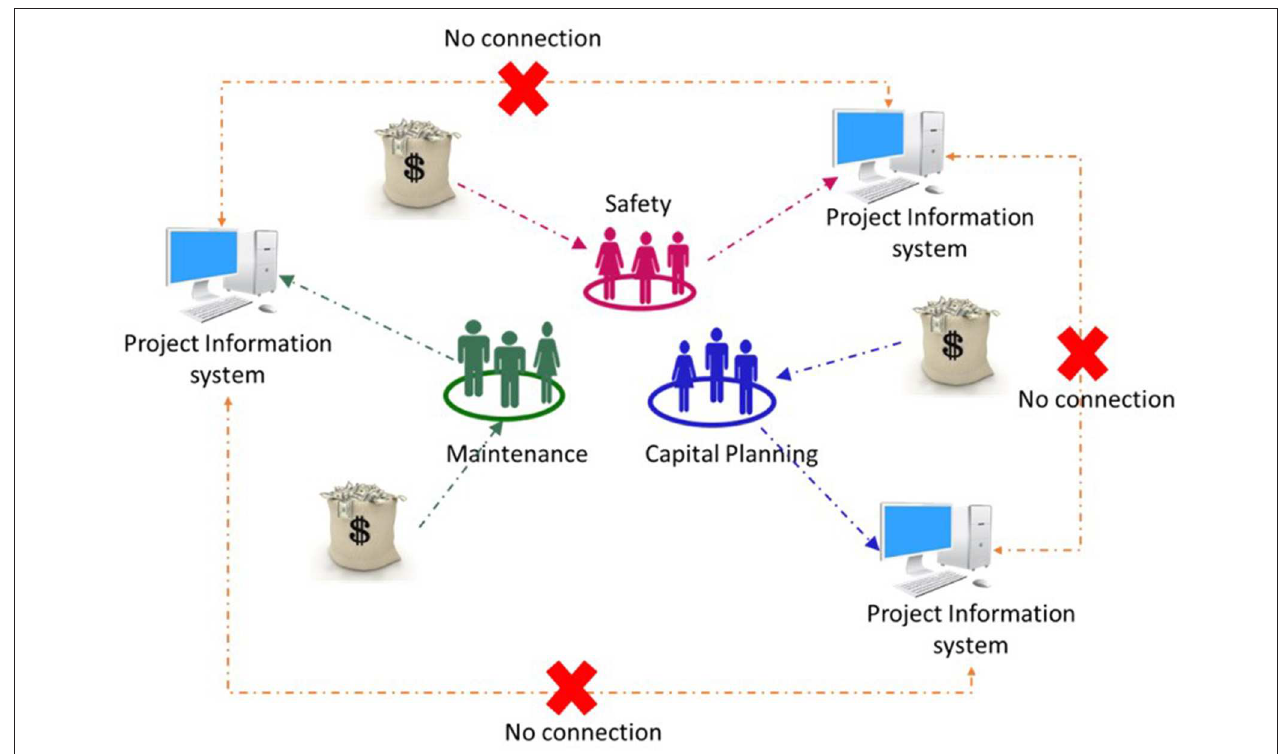
FIGURE 1 | Conceptual diagram of funding and disjoint information systems of functional groups in